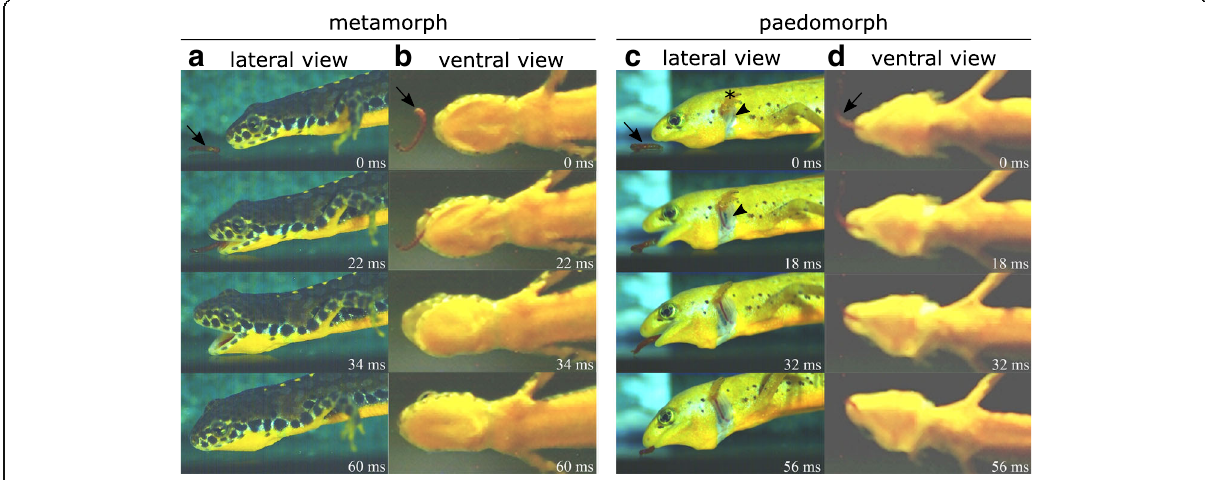
Fig. 2 Frame-shots showing the prey strike in metamorphic ( a and b ) and paedomorphic ( c and d ) alpine newts from lateral ( a and c ) and ventral views ( b and d ). The prey ( Chironomus larva) is indicated by arrows. Note that the paedomorphic animal exhibits well-visible gill openings (arrowhead) just beneath the external gills (asterisk), which are absent in the metamorphosed